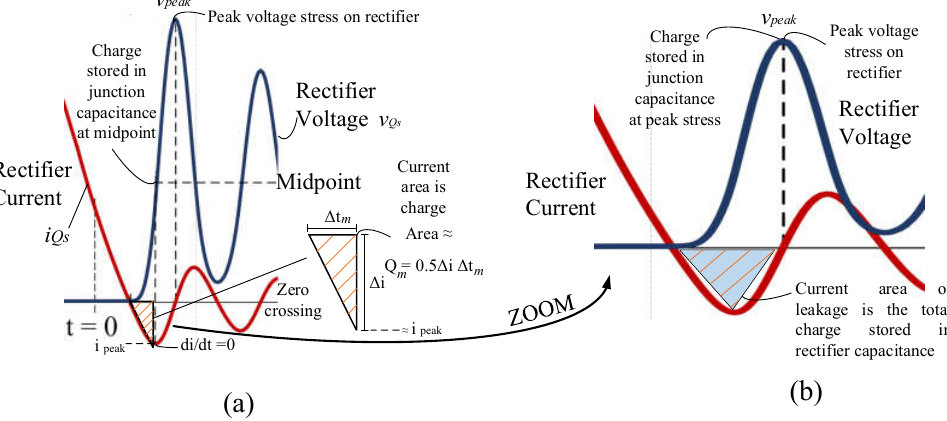
Figure 9. Rectifier waveform during turn off transient ( a ) charge at midpoint ( di/dt = 0) is for peak current estimation ( b ) total charge is for peak voltage stress estimation.